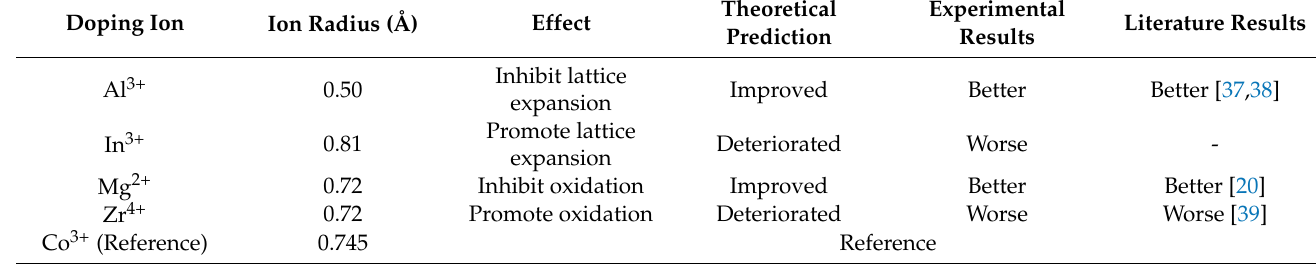
Table 1. The theoretical prediction, experimental results, and literature results of the cycling performance for doped LiCoO 2 . Doping Ion